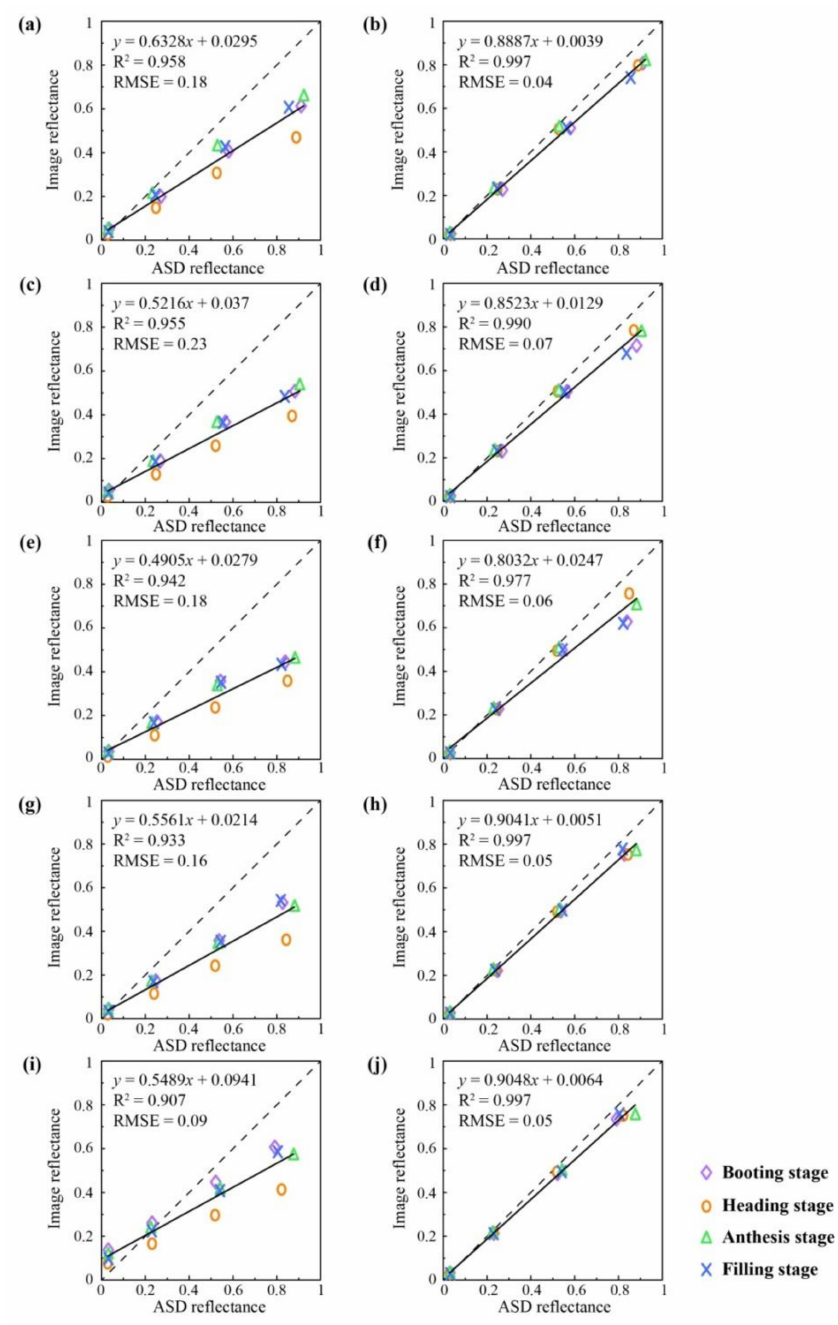
Figure 11. Comparison of the analytical spectral device (ASD) reflectance with the calibrated values for five bands at four growth stages with the light intensity sensor correction (ILSC) and empirical linear correction (ELC) radiometric correction methods. Panels ( a – b ), ( c – d ), ( e – f ), ( g – h ), and ( i – j ) are the plots for the MAC-1, MCA-0, MAC-2, MAC-3, and MAC-4, respectively. The two columns from left to right correspond to the radiometric correction methods ILSC and ELC,